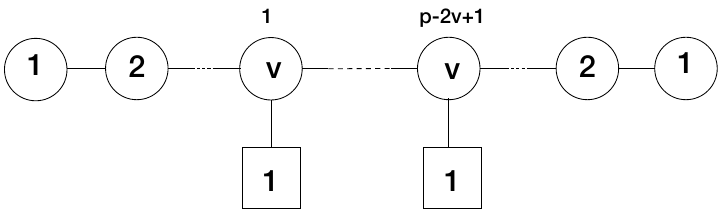
Figure 6 . The Kronheimer-Nakajima quiver associated to a ’t Hooft loop labelled by B = ( p; 0) in the sector v = ( v; p (cid:0) v ) (where v 6 = p (cid:0) v ) in an N = 2 (cid:3) U(2) theory.